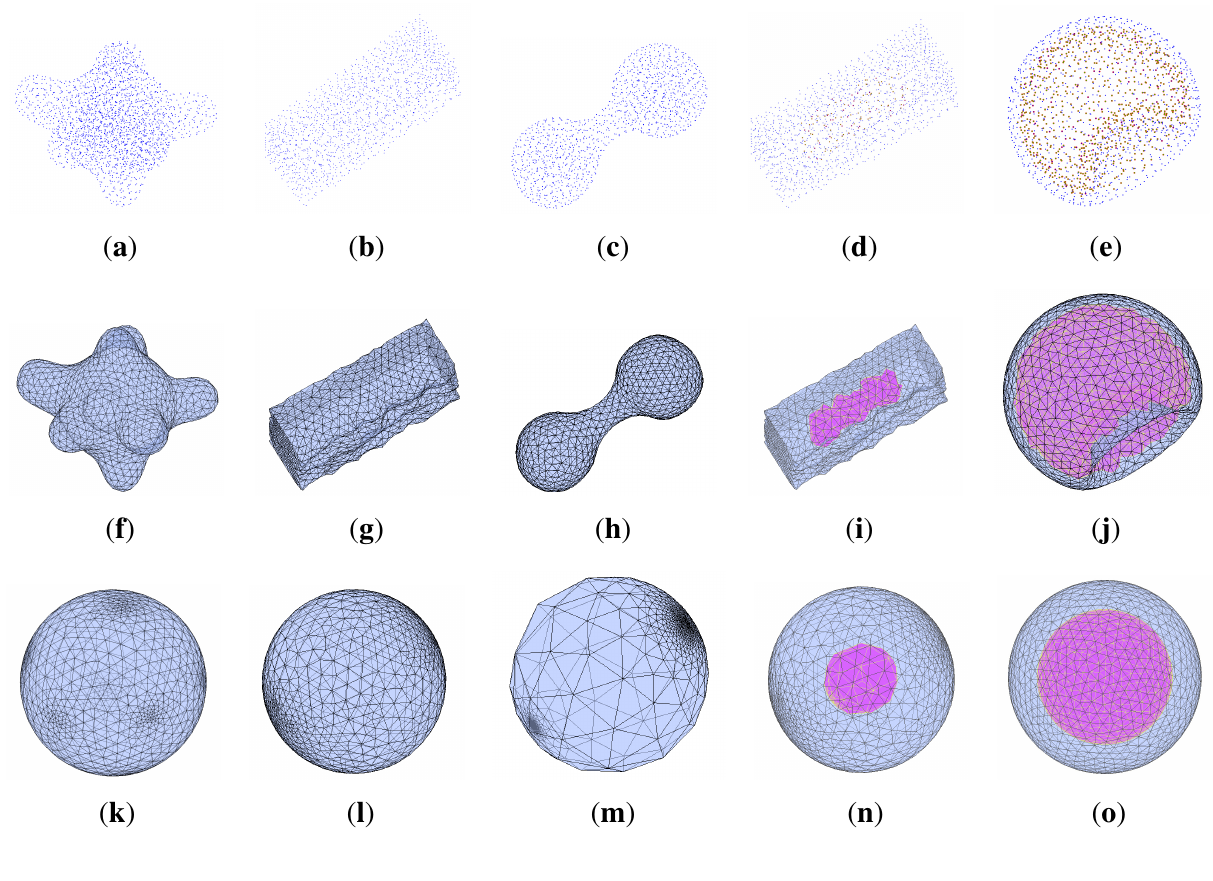
Figure 6. 3D network models and mapping results, where the first row shows original networks, the second row illustrates the established UTC mesh structures with only boundary UTCs, for conciseness, and the third row depicts the results after volumetric harmonic mapping (VHM). The inner boundary is highlighted in magenta. ( a ) Network Model